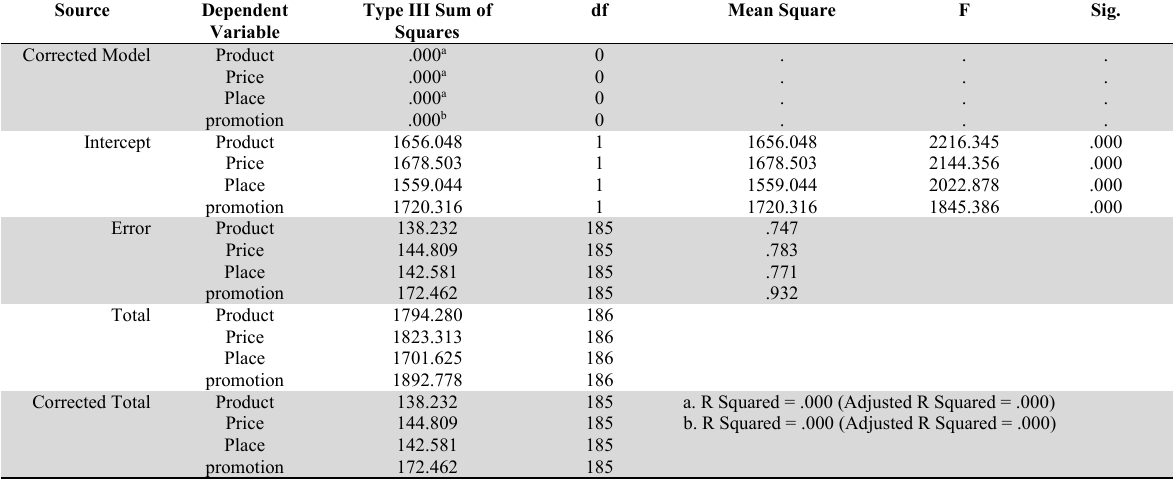
Tests of Between-Subjects